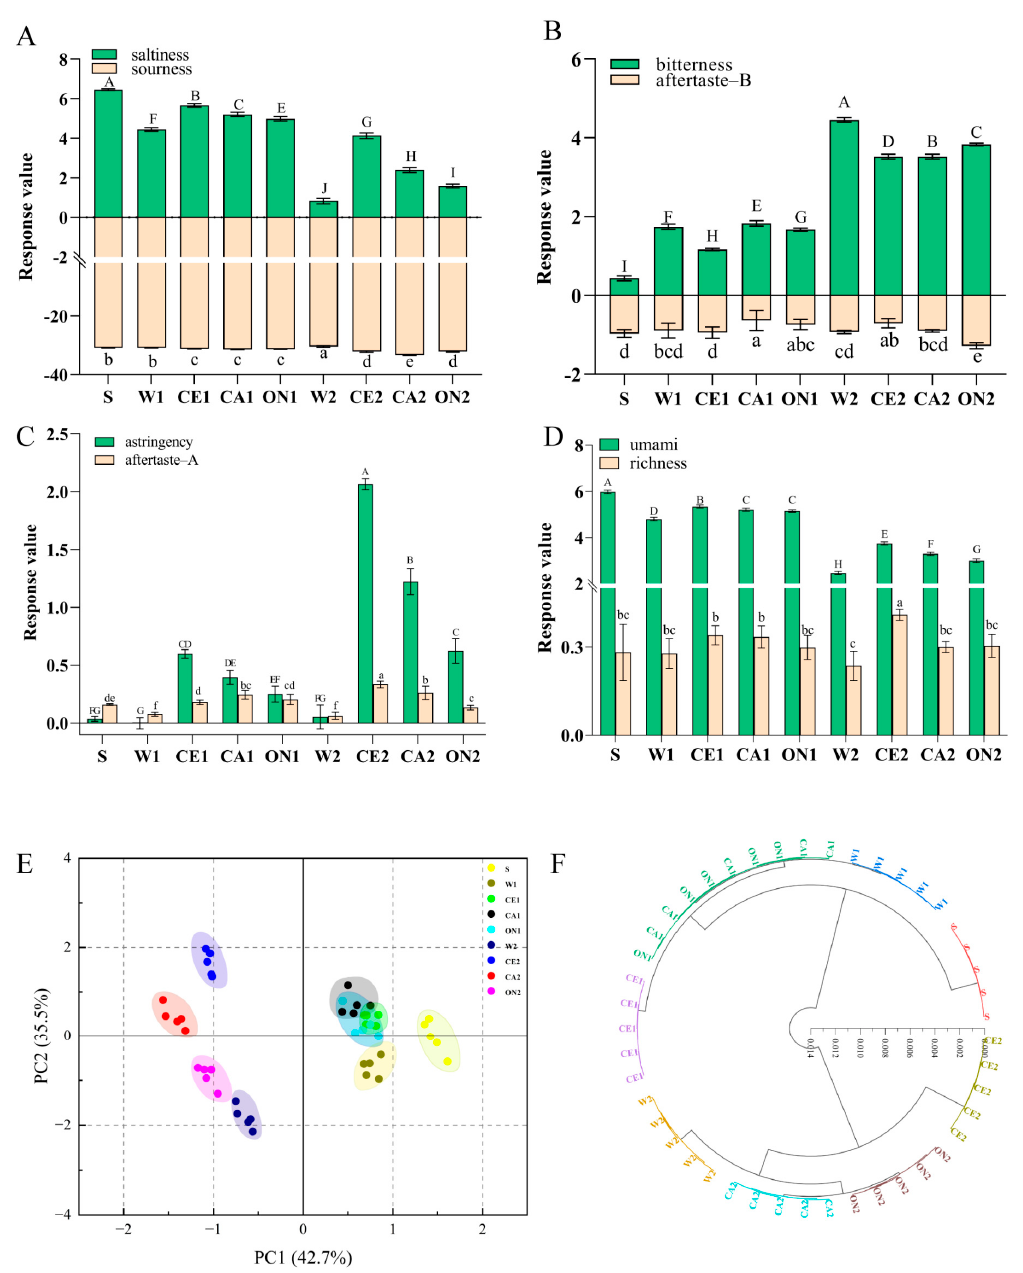
Figure 3. Saltiness and sourness ( A ), bitterness and bitterness aftertaste ( B ), astringency and astringency aftertaste ( C ), umami and richness ( D ) of different soy sauces; PCA score plot ( E ) and HCA analysis plot ( F ) of soy sauce taste based on electronic tongue response data. Different letters represent significant differences between groups ( p < 0.05).